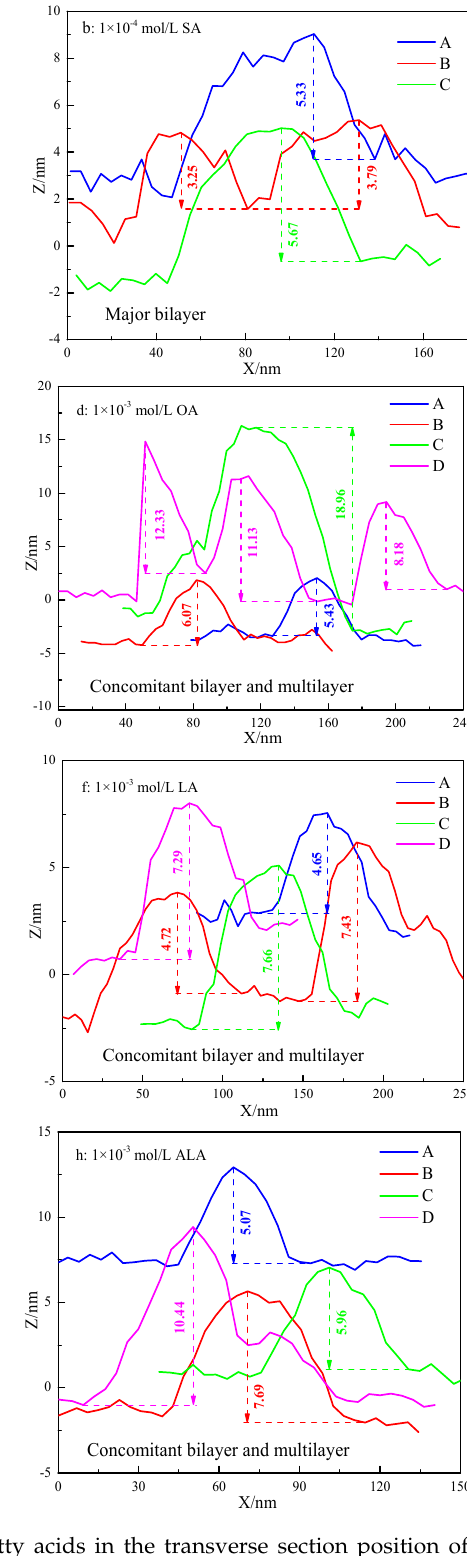
Figure 13. The homologous height of adsorbed fatty acids in the transverse section position of Figure 12, ( a ) 1 × 10 − 6 mol / L SA, ( b ) 1 × 10 − 4 mol / L SA; ( c , e , g ) 1 × 10 − 5 mol / L OA, LA, ALA respectively; ( d , f , h ) 1 × 10 − 3 mol / L OA, LA, ALA